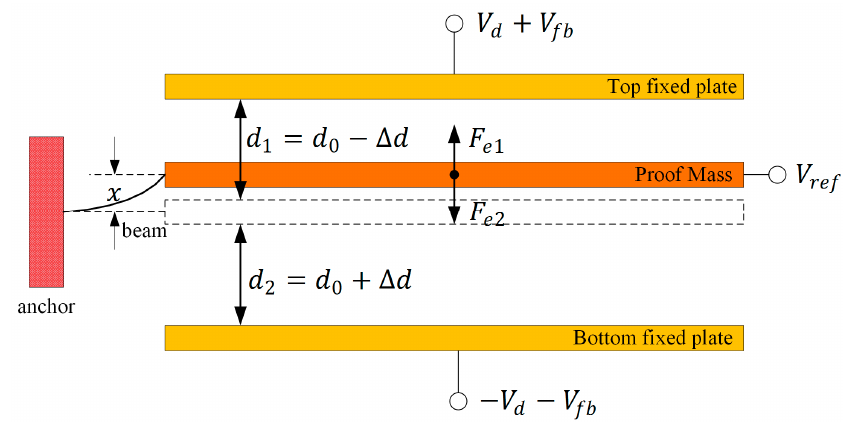
Figure 2. Sensor working diagram of electrostatic force balance.